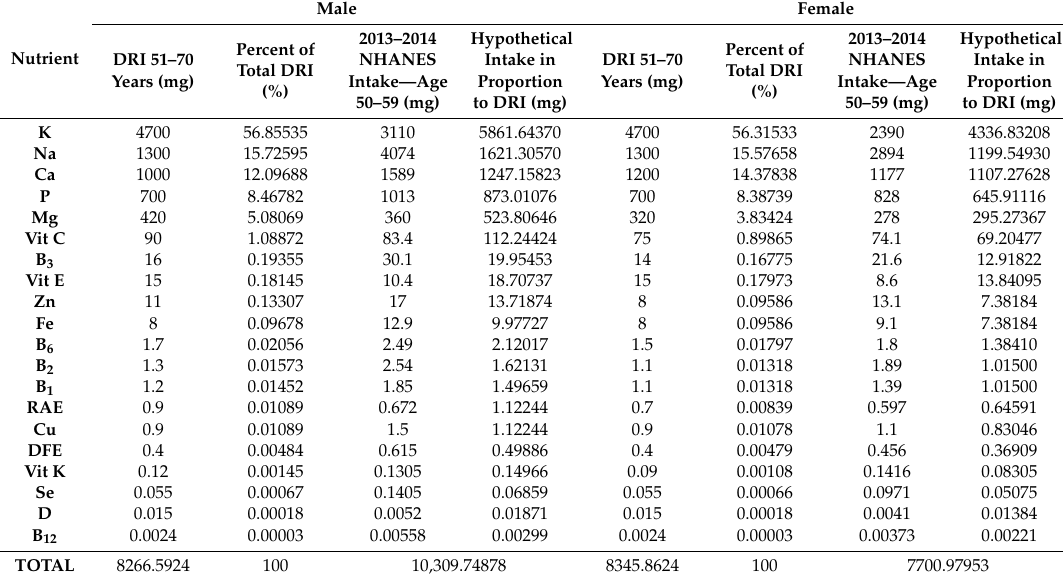
Table 7. Micronutrient Dietary Reference Intakes (DRI) for males and females 51–70 years, the percentage contribution of each micronutrient to the total, the intakes from National Health and Nutrition Examination Survey (NHANES) 2013–2014 data, for males and females, from food, aged 51–59 years and the projected intake, per DRI proportions, based on the total